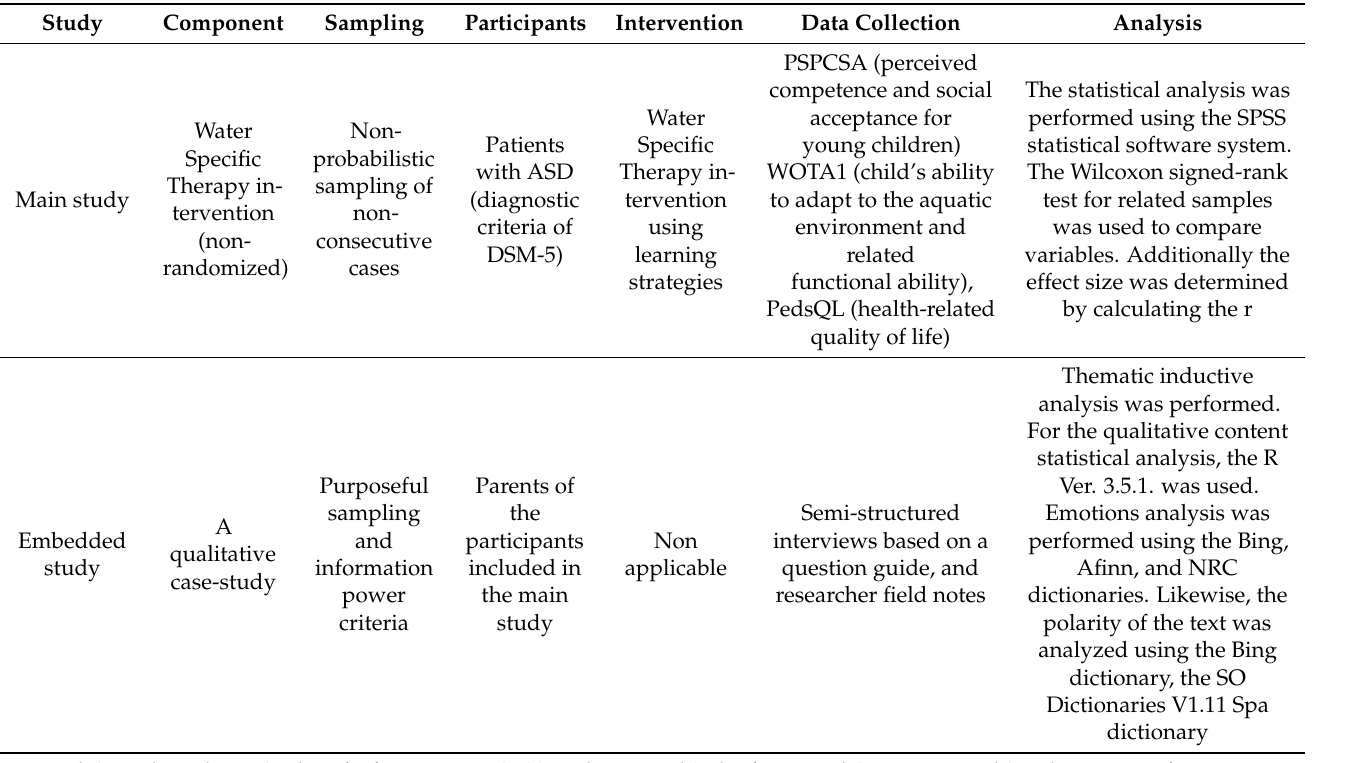
Table 1. Mixed methods intervention study summary.